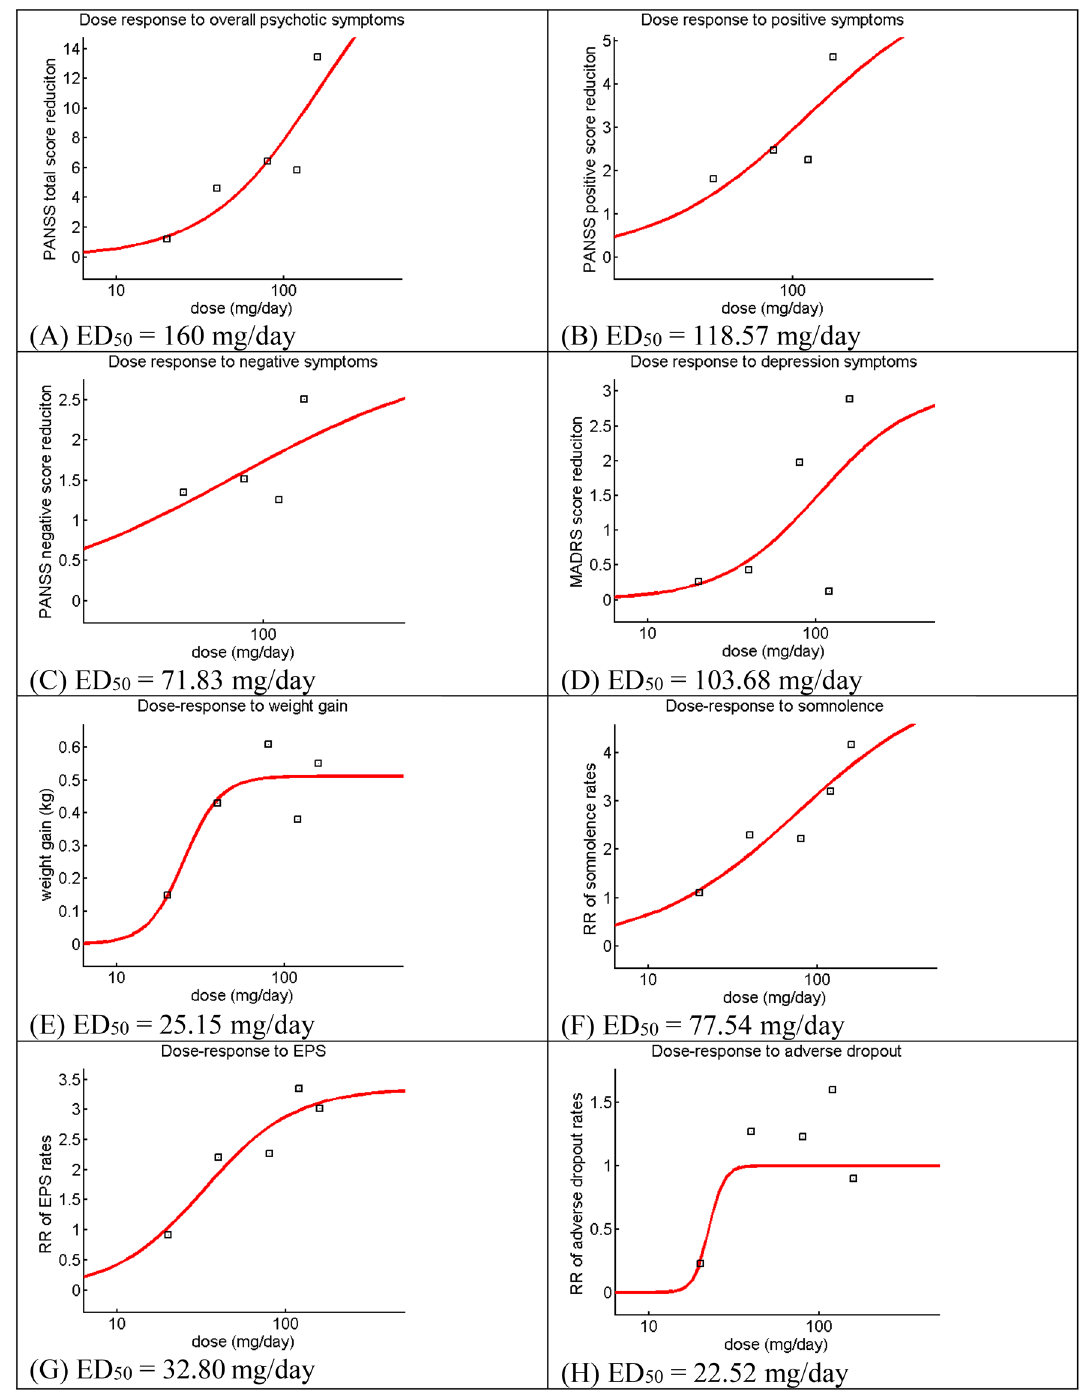
Figure 4. Dose–response curves: therapeutic and adverse effects of lurasidone at different doses for acute schizophrenia. Each curve was plotted with the lurasidone doses on the x-axis and the point NMA estimates of lurasidone against placebo on the y-axis. Figure 4A and 4D–4H include five doses of 160, 120, 80, 40, and 20 mg/day. Figure 4B and 4C include four doses of 160, 120, 80, and 40 mg/day. ED 50 = half-maximal effective dose, EPS: Extrapyramidal side effects, PANSS: Positive and Negative Syndrome Scale, MADRS: Montgomery- Asberg Depression Rating